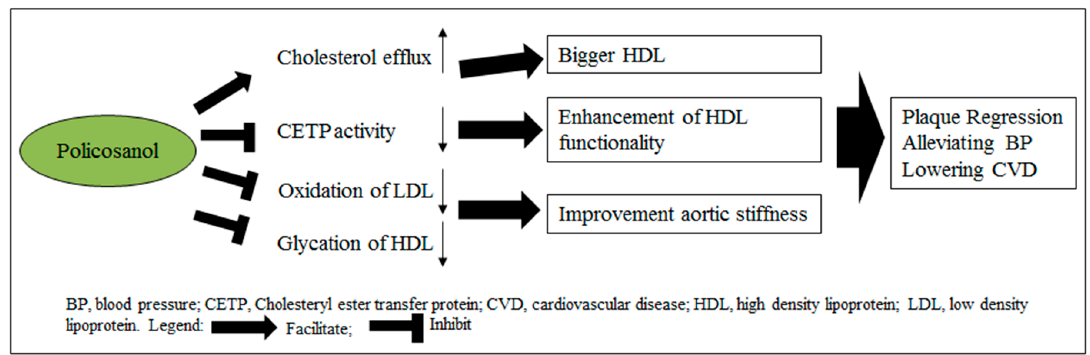
Figure 9. Proposed flow chart elucidating the mechanism of policosanol in lowering blood pressure. From Pearson’s correlation analysis, SBP and DBP at week 0 were shown to be inversely correlated with tail blood flow rate and tail blood volume. However, at week 8, the relationship changed to be positive in a dose-dependent manner, especially in the SHR + 200 mg of policosanol group. Previously these parameters were used to monitor blood pressure in various models [34,35].